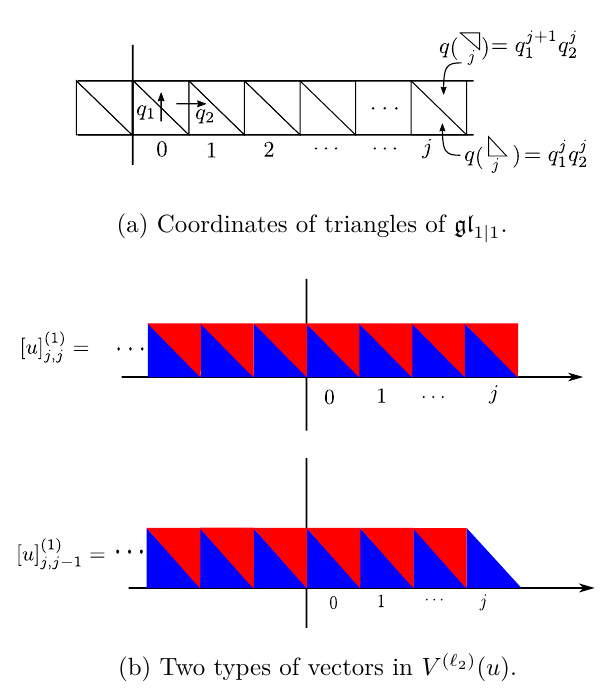
Figure 18. Coordinates and basis of the one-dimensional crystal representation. (a) The triangle with the oblique side up is the blue triangle and the triangle with the oblique side down is the red triangle. The blue triangle has coordinate q j [ u ] (1) has j + 1 blue triangles and j + 1 red triangles right to the border, while [ u ] (1) j,j blue and j red